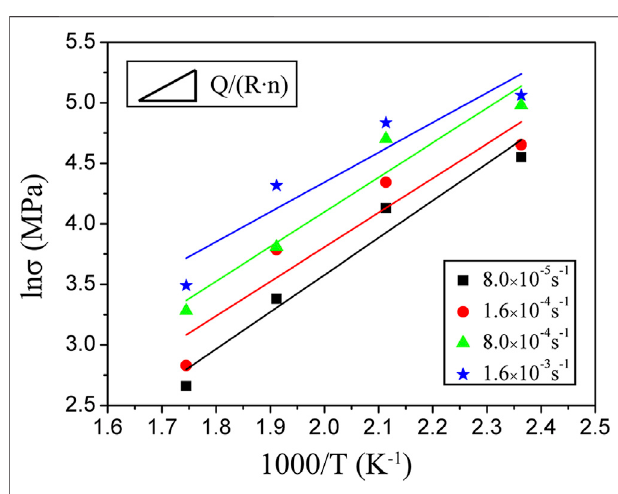
FIGURE 12 | Strain rate sensitivity exponents calculated by fi tting ln σ − ln _ ε .